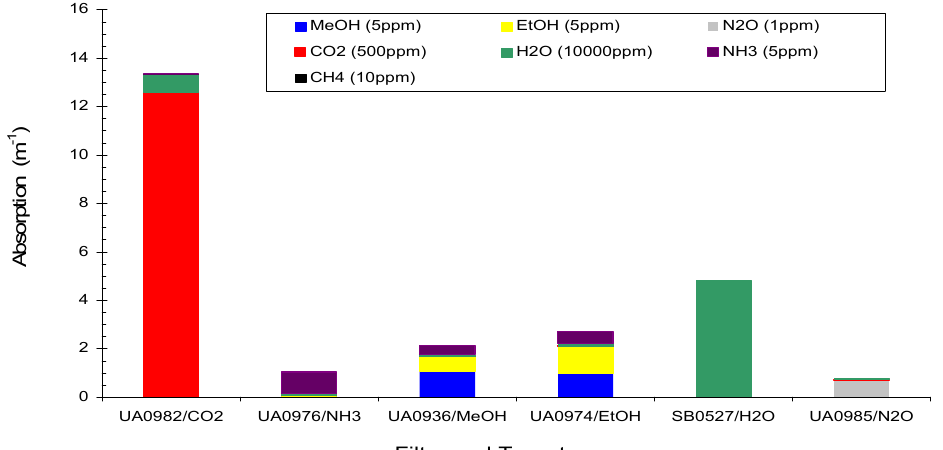
Figure 3. Absorption of Example #2 target gases (NH MeOH = 5 ppm, EtOH = 5 ppm, N = 10 ppm) at each (CH 4